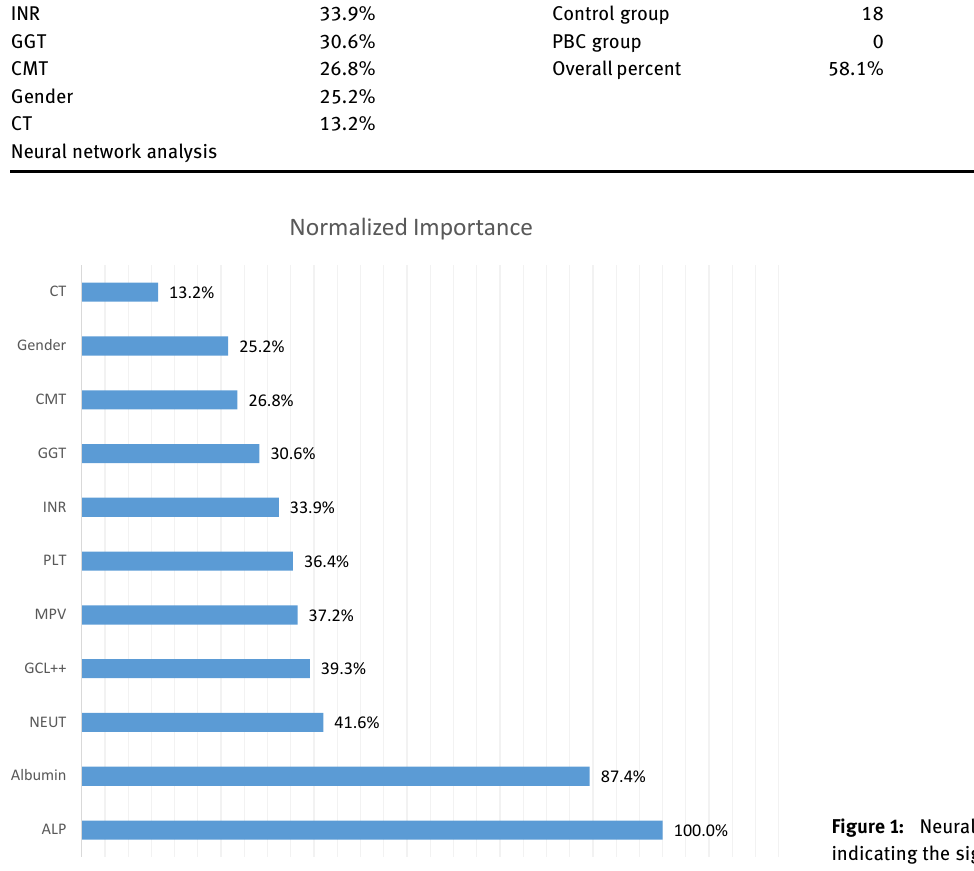
Figure 1: Neural network analysis for indicating the significance of